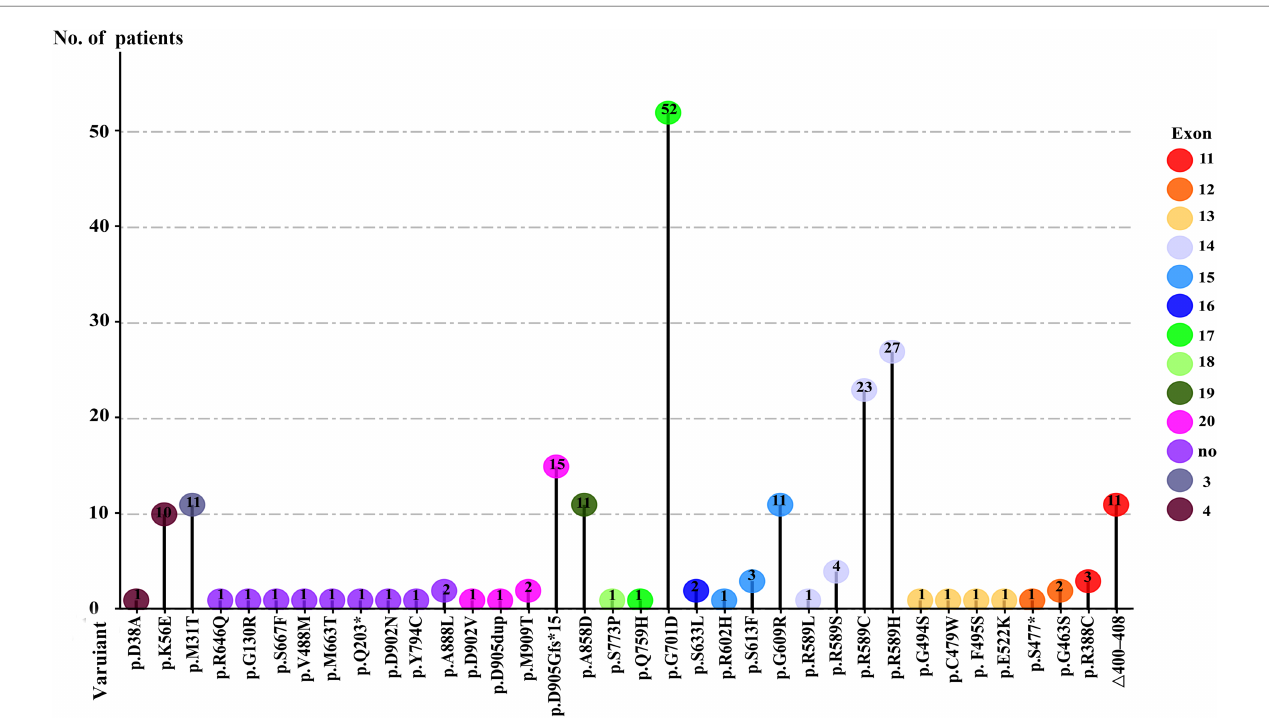
FIGURE 2 Frenquency of mutations at each mutation site.